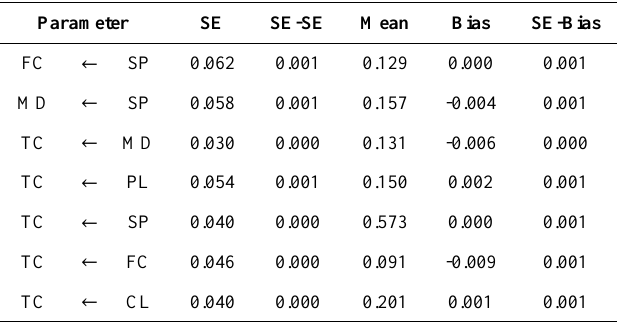
Table 4. Testing bootstrap with 50.000 samples for factors affecting the green bank